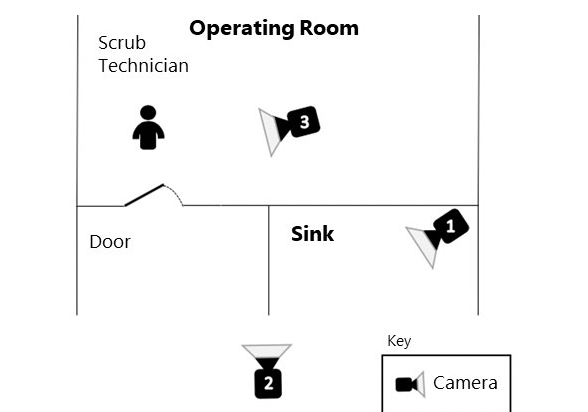
Figure 1. Schematic of Study Setup